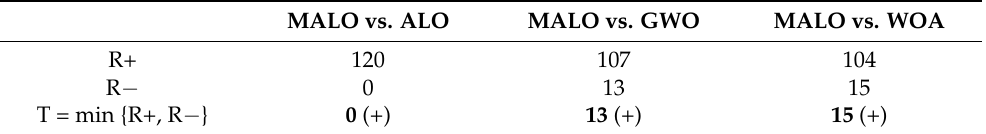
Table 16. The t values of significance test on averaged bacc between MALO vs. ALO, MALO vs. GWO, and MALO vs. WOA. MALO vs. ALO MALO vs. GWO MALO vs. WOA R+ 120